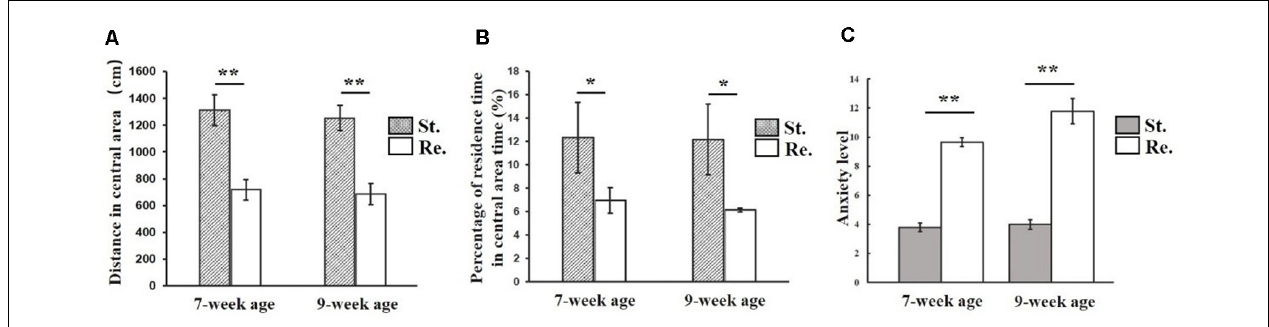
FIGURE 2 | Cage effects on exploration and anxiety level of mice. (A) The distance traveling in central area decreased in restricted cage group; (B) the residence time in central area was decreased in restricted cage group; (C) the anxiety level of restricted cage group was increased significantly. The error bars mean standard deviations. Statistically significant differences compared with standard cage group. * P < 0.05, ** P < 0.01, n = 40 per group. St., standard cage groups; Re., restricted cage groups.